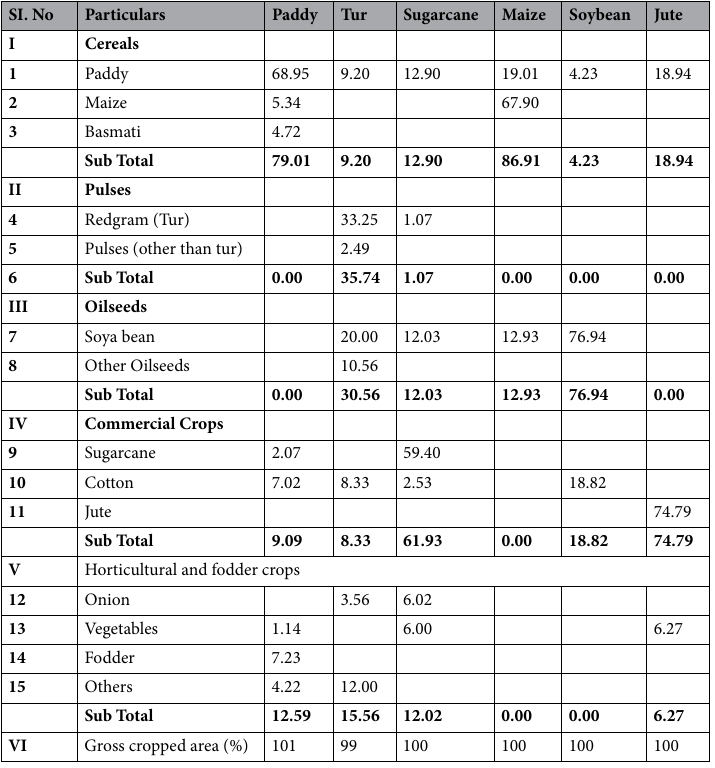
Table 5. Crop-wise, Cropping Pattern adopted by the sample farmers in the study area (%). Source: Authors’ estimates using field survey data.